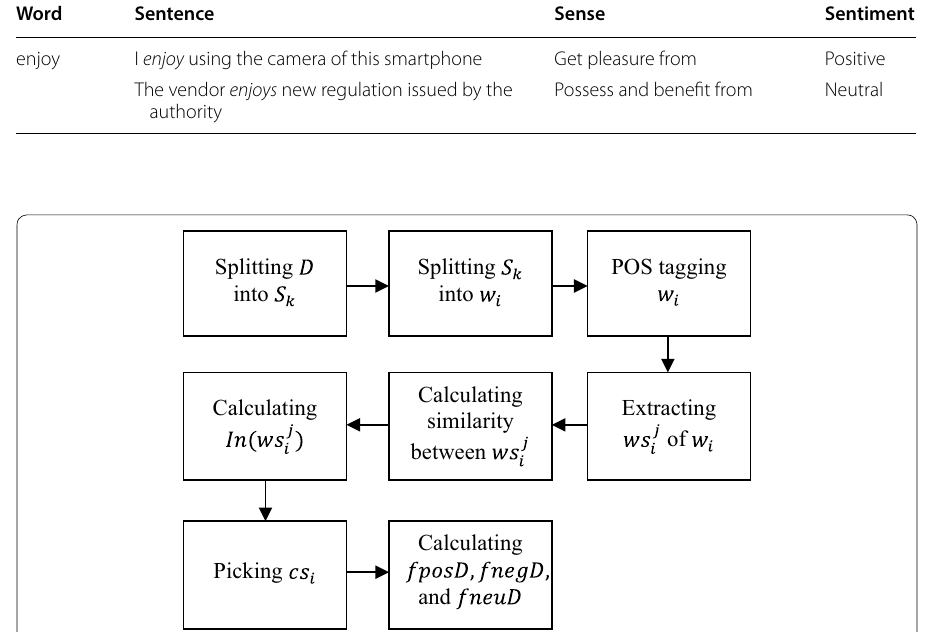
Fig. 1 The calculation of fposD , fnegD , and